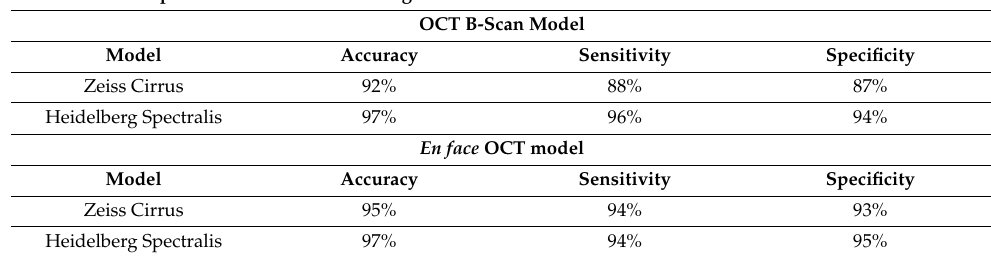
Table 3. Summary of the comparison of pixel-wise GA segmentation performance for both OCT B-scan and en face OCT models between the device manufacturers included in this study. Heidelberg Spectralis HRA+OCT (Heidelberg Engineering, Heidelberg, Germany) and Cirrus HD-OCT (Zeiss, Oberkochen, Germany) devices were used in this study for image capture. GA: geographic atrophy, OCT: optical coherence